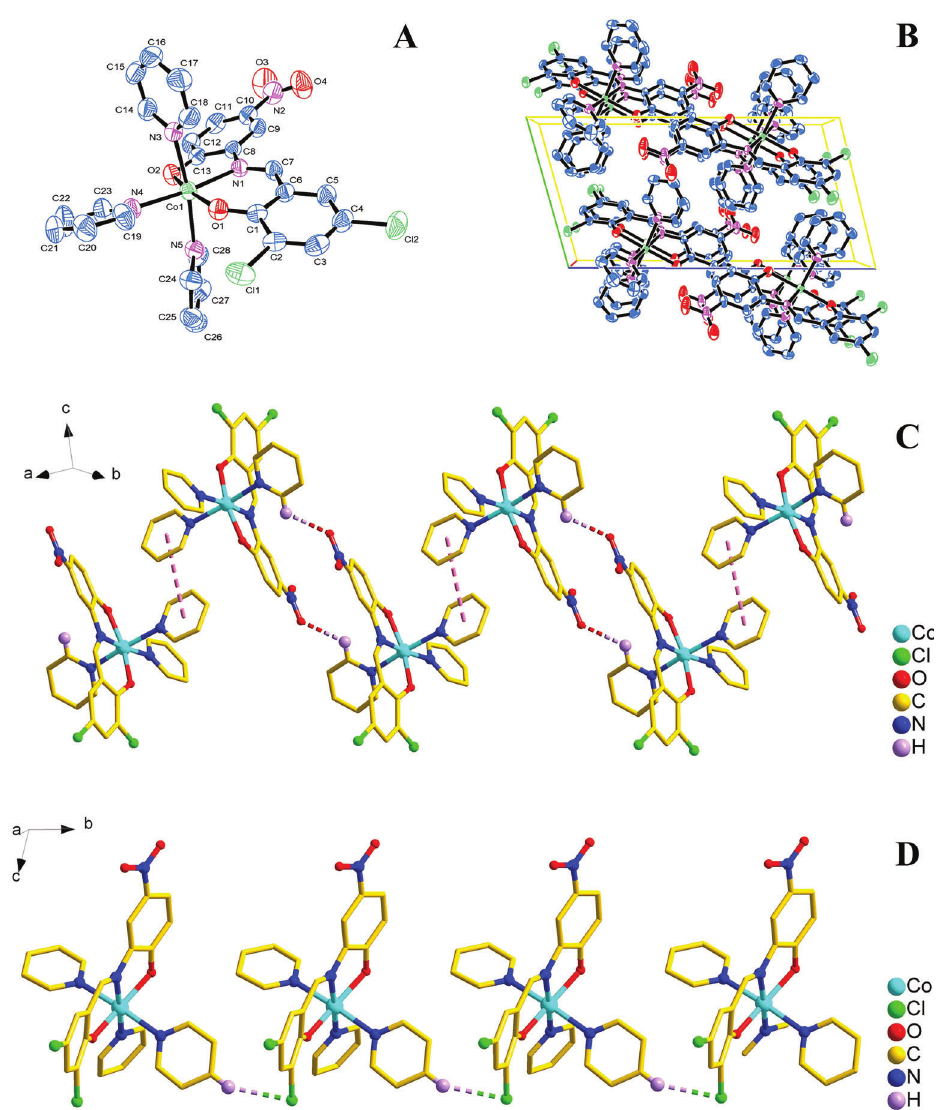
Figure 2. A , Molecular structure of compound 1 (Py 3 CoL 1 ); B , packing of compound 1 in unit cell; C , 1D in fi nite chain structure of compound 1 was formed by the p y p and C-H y O interactions; D , 1D in fi nite chain structure of compound 1 was formed by the C-H y Cl